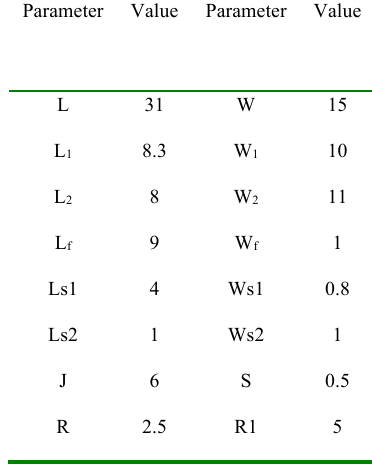
TABLE I. The optimized dimensions of the adopted single antenna in